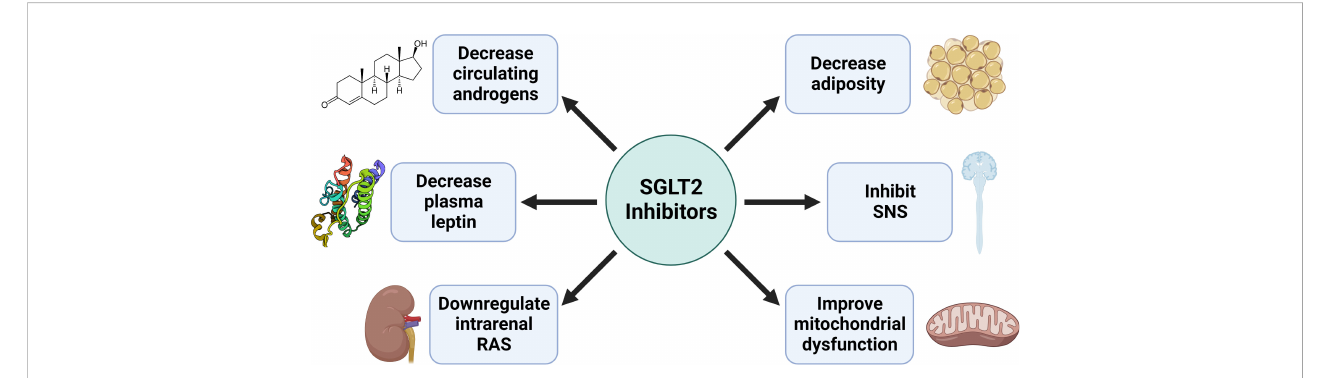
FIGURE 3 Potential mechanisms by which SGLT2 inhibitors improve the cardiometabolic complications in